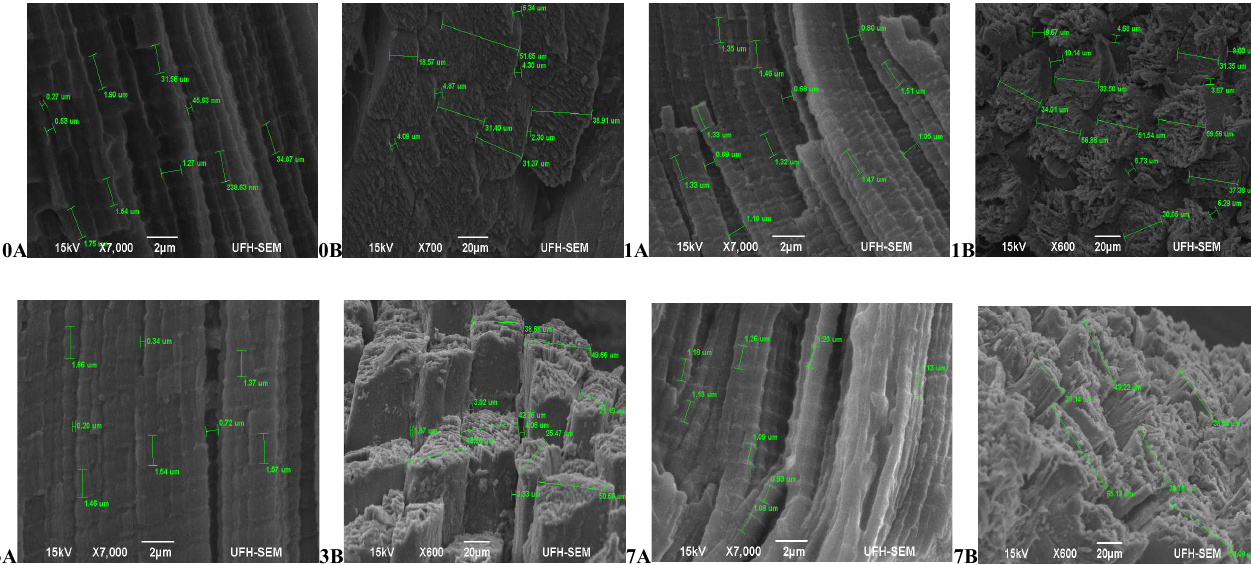
Figure 2. Transverse and Lateral muscle nanostructure changes of Beef master during a 7 day ageing period; observed under the JEOL JSM-6390LV scanning electron microscope (SEM) and further viewed using JEOL JM-5600 SEM at ×5,000 magnification. A, Lateral muscle structure from day 0, 1, 3, and 7 ageing period; B, transverse muscle structure from day 0, 1, 3, and 7 ageing period. μm, micrometre.